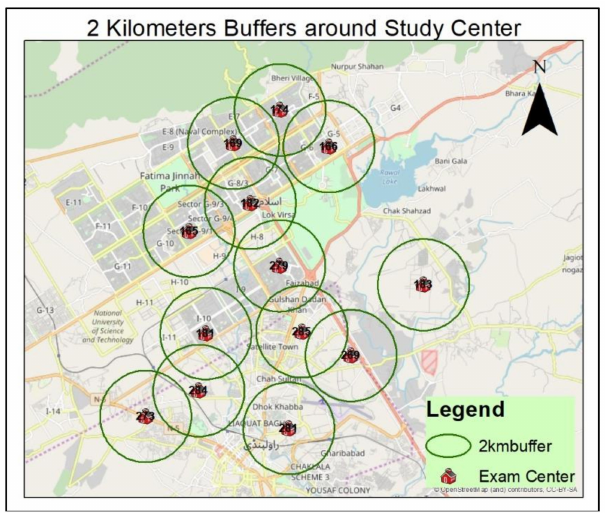
Figure 5. Two kilometer buffer around study